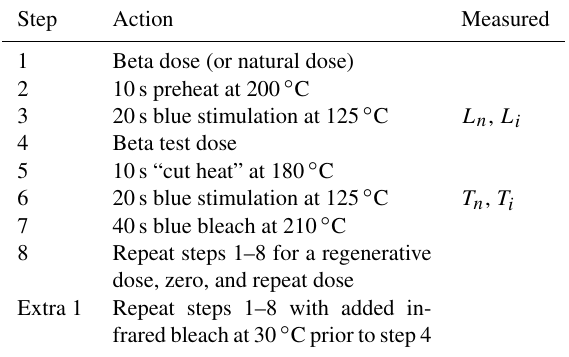
Table 2. The SAR protocol used for equivalent dose measurement, including measurement parameters.